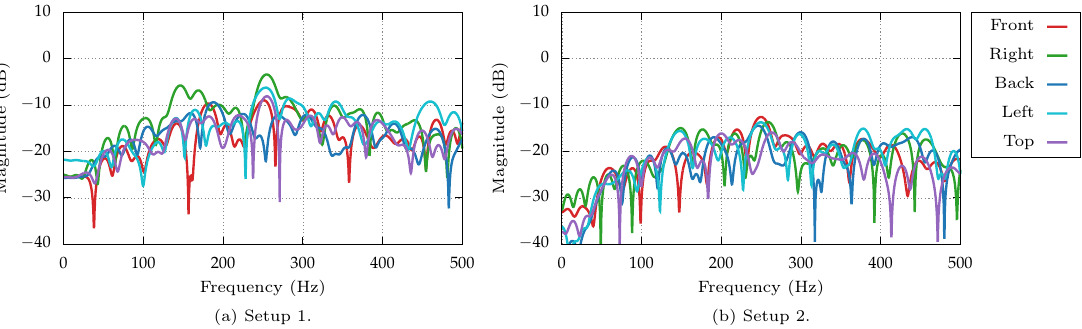
Figure 7. The amplitude functions of the frequency functions of the impulse response estimates for the secondary paths between each casing panel’s selected actuator and the error microphone adjacent to the right casing panel, at a distance of 0.1 m, in both setups.